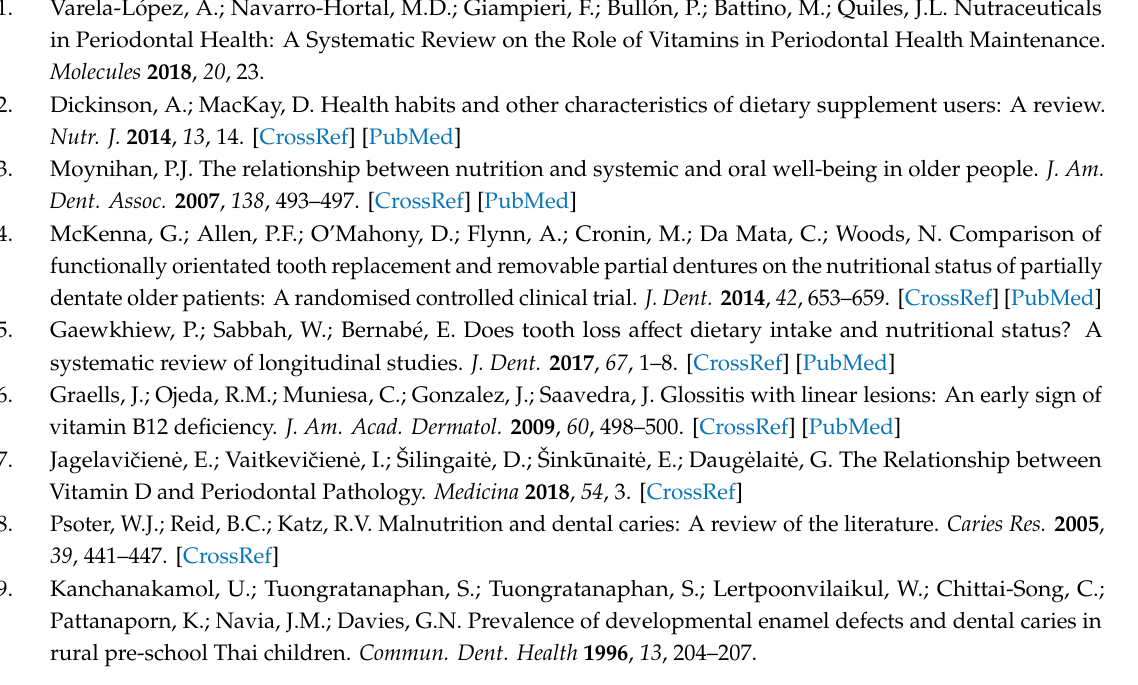
Table S1: List of excluded papers, Table S2: Quality Assessment, Table S3: List of excluded papers after full text